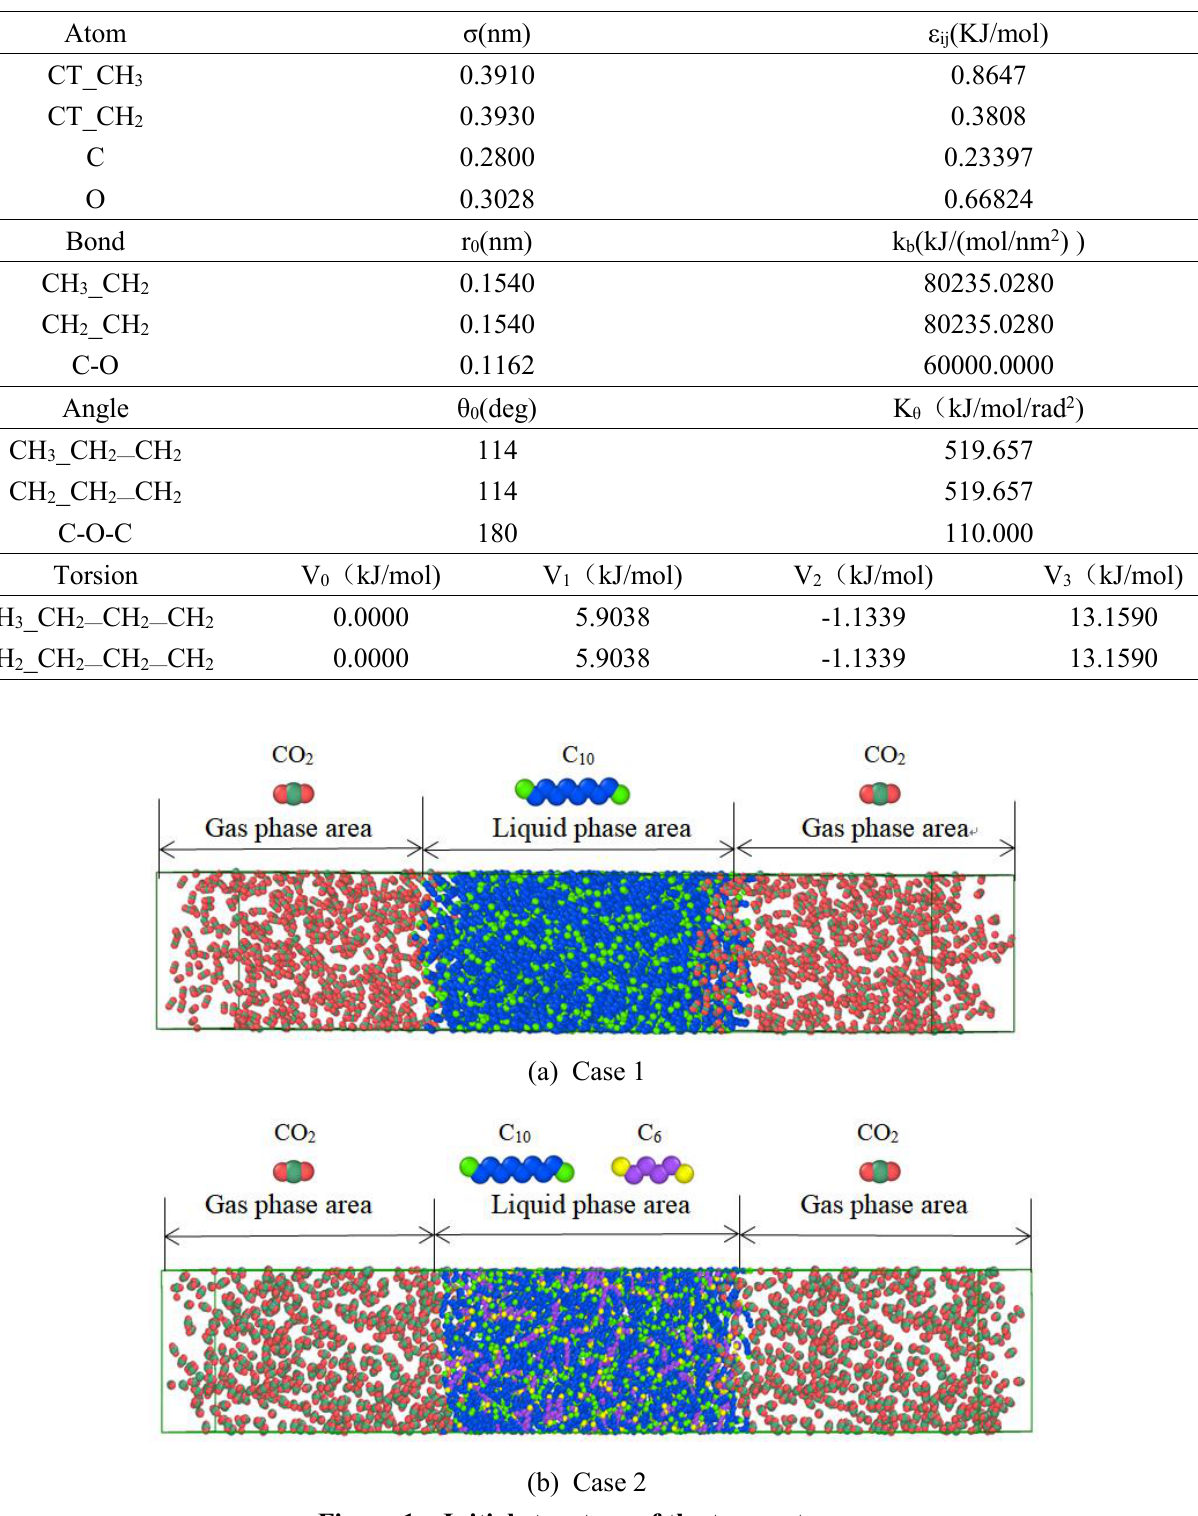
Figure 1 — Initial structure of the two